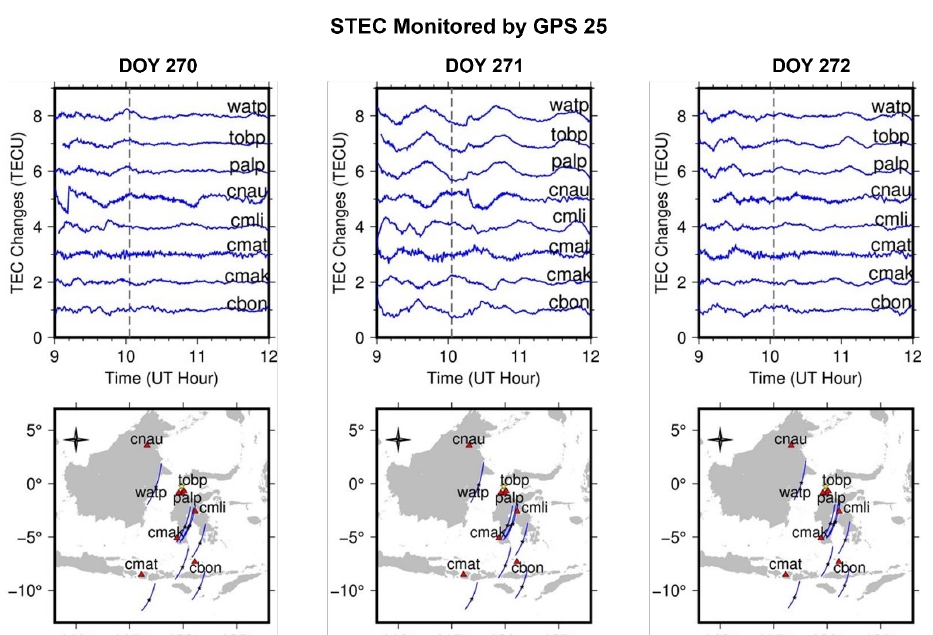
Figure A4. The slant changes of TEC in GPS PRN 25 one day prior and after the earthquake in which the TEC changes occurred. The black vertical dashed lines in the time series indicate the time span of the 2018 Palu Sumatra earthquake mainshock (10:02:45 UT). The small black stars indicate the SIP on the trajectories during mainshock event. The yellow stars indicate the epicenter, and the red triangle indicates the GPS stations.